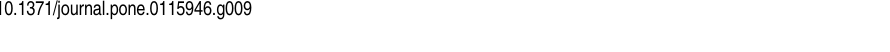
Fig. 9. Diel temperature preferences for whale sharks at Darwin Island. Percent of time expended by the four sharks tracked at different water temperature during day and night